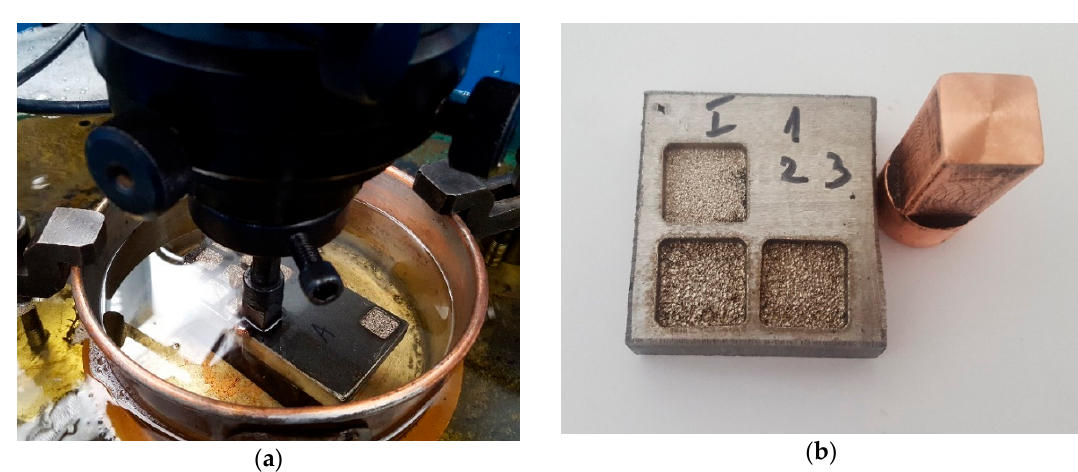
Figure 1. EDM set-up: ( a ) Copper pot incorporated into the machine tank; ( b ) Copper electrode. Table 2. Properties of electrode’s material Table 1. Process variables and their control levels.